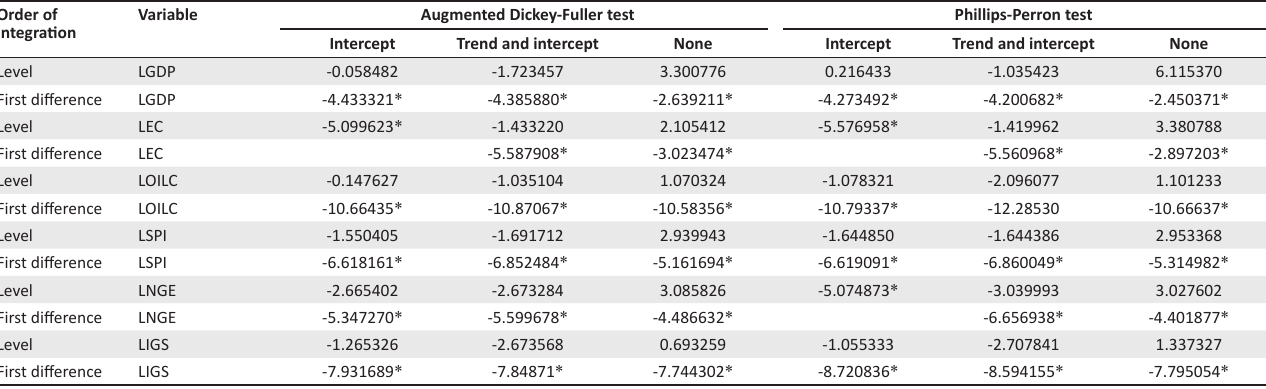
TABLE 1: Unit root test results, 1980–2012.